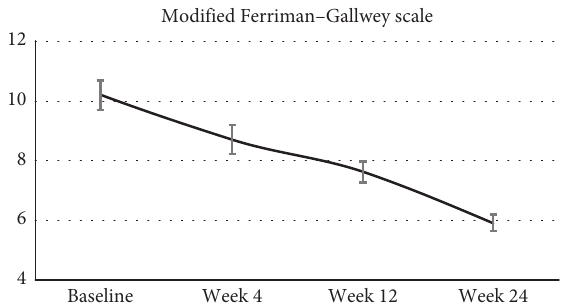
Figure 5: Modified Ferriman–Gallwey scale for scoring hirsutism (mFGHS). The data represent the mFGHS analysis made during each visit (baseline or week 0, week 4, week 12, and week 24). The error bars are average ± SEM.